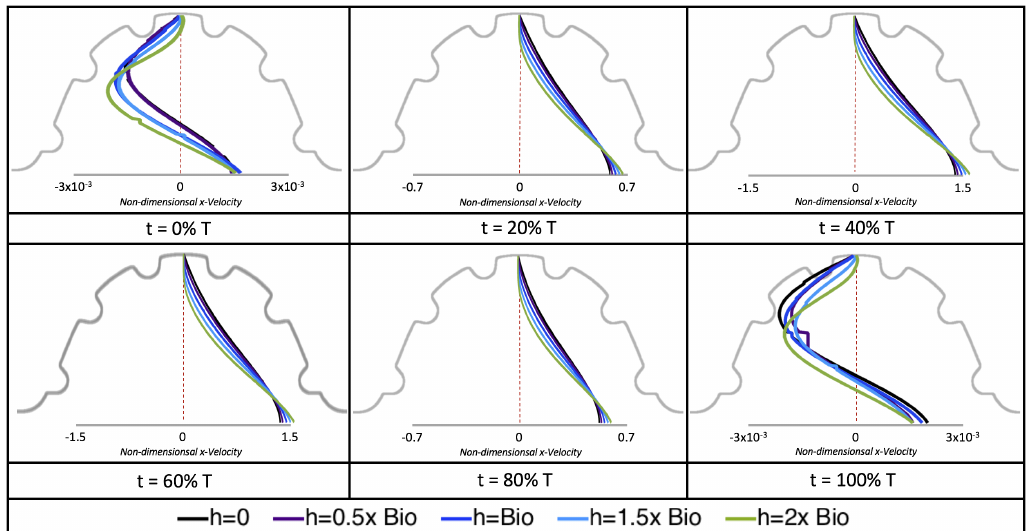
Figure 21. Snapshots during a pulsation cycle in the Re = 1 case of the horizontal velocity measured from the intracardial center to the intertrabecular region directly above for multiple trabeculae heights. Each sub-figure corresponds to a different time point described as a percentage of the pulsation cycle, T .